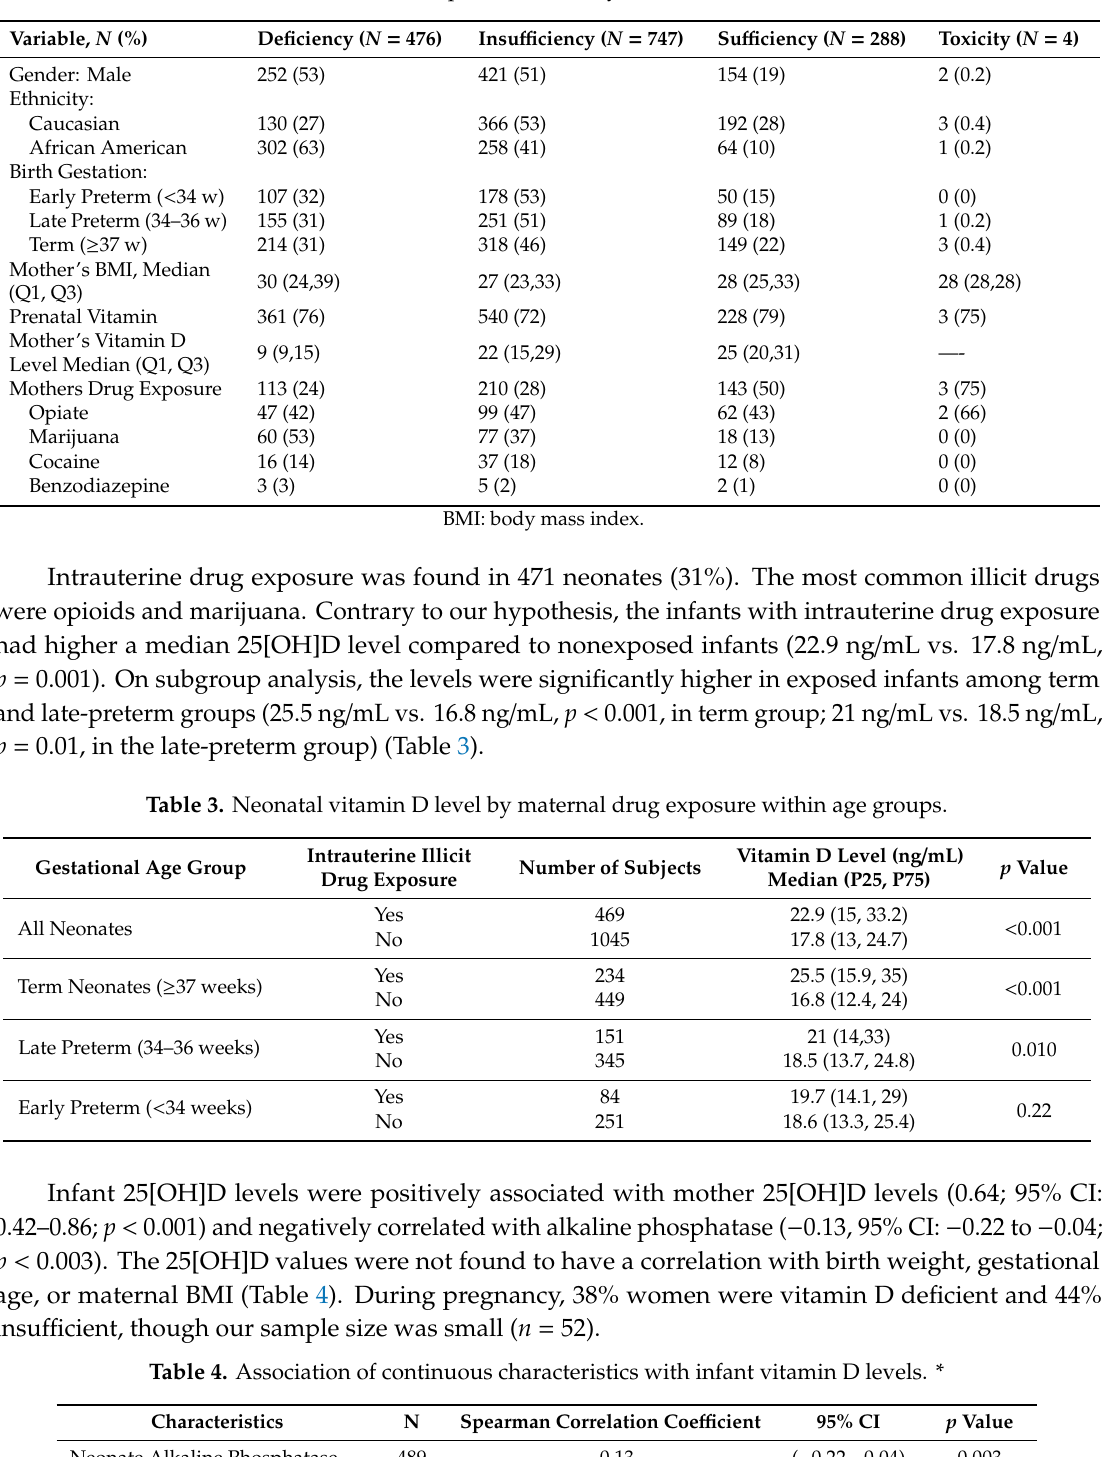
Table 2. Descriptive statistics by vitamin D status.